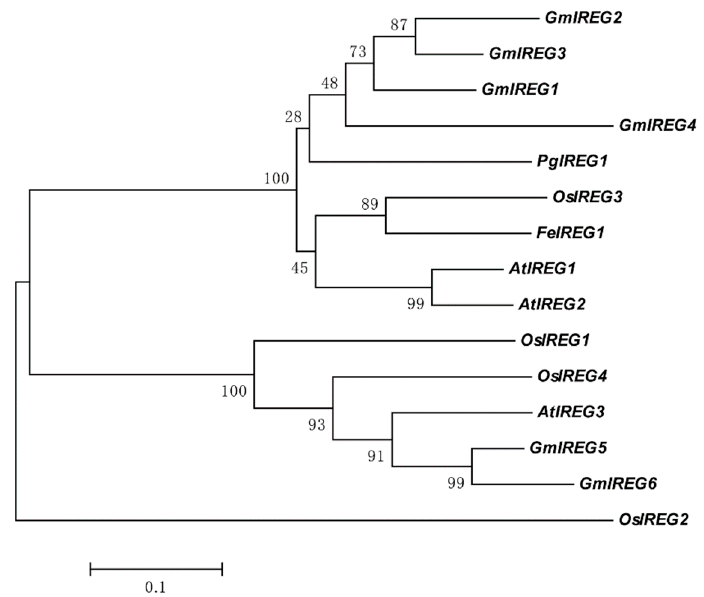
Figure 1. Phylogenetic analysis of the GmIREGs and published IREG proteins. The phylogenetic tree was constructed using the neighbor-joining method with 1000 bootstrap replicates by MEGA 7.0